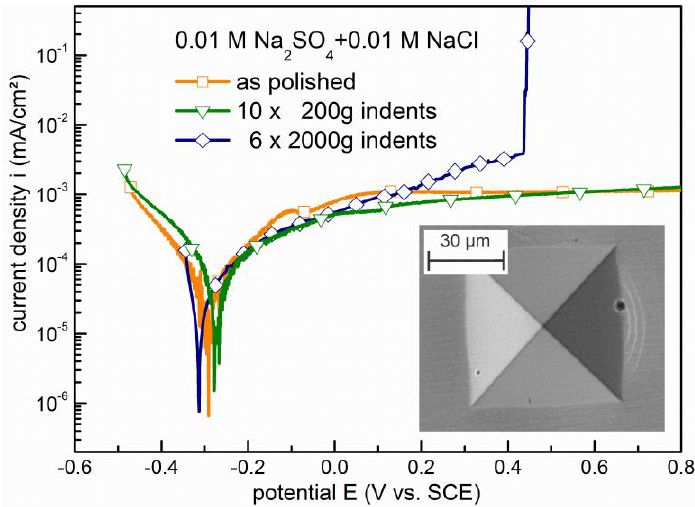
Figure 1. Anodic potentiodynamic polarization curves of bulk glassy Zr 59 Ti 3 Cu 20 Al 10 Ni 8 alloy in the as polished state and after applying Vickers micro-indent arrays with two different loads.